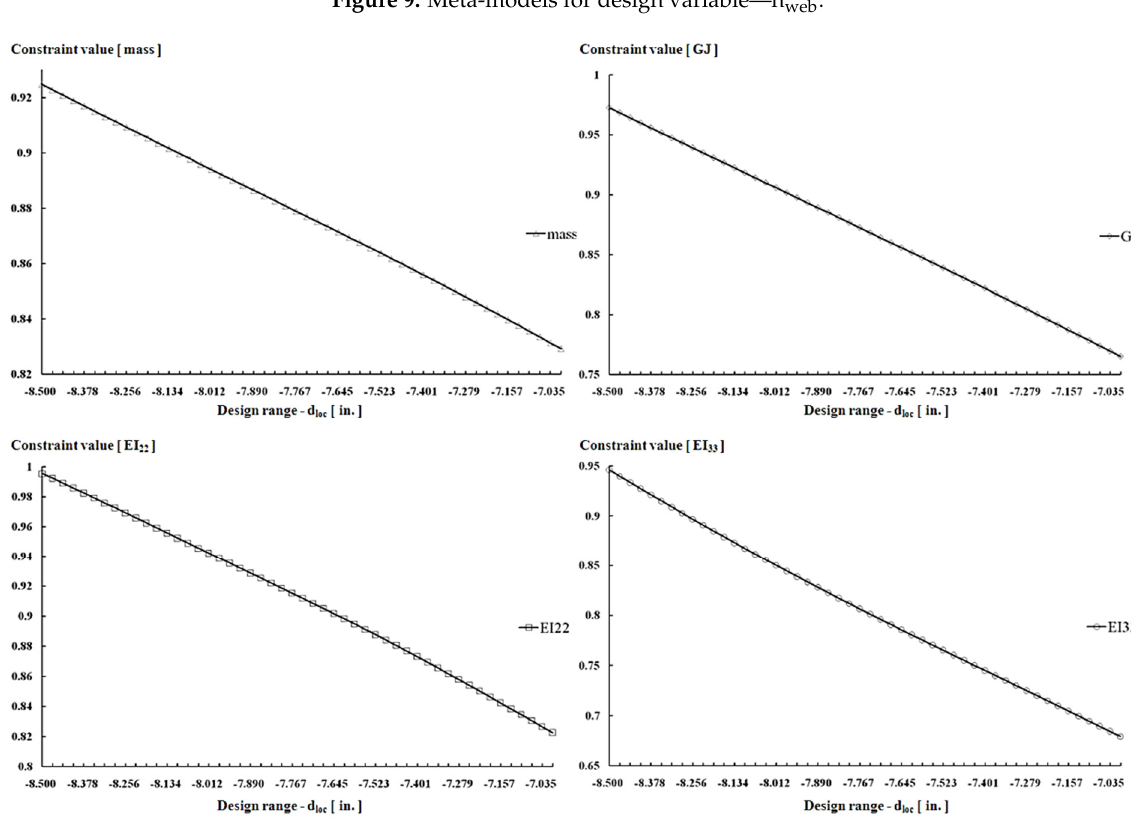
Figure 10. Meta-models for design variable—d loc .